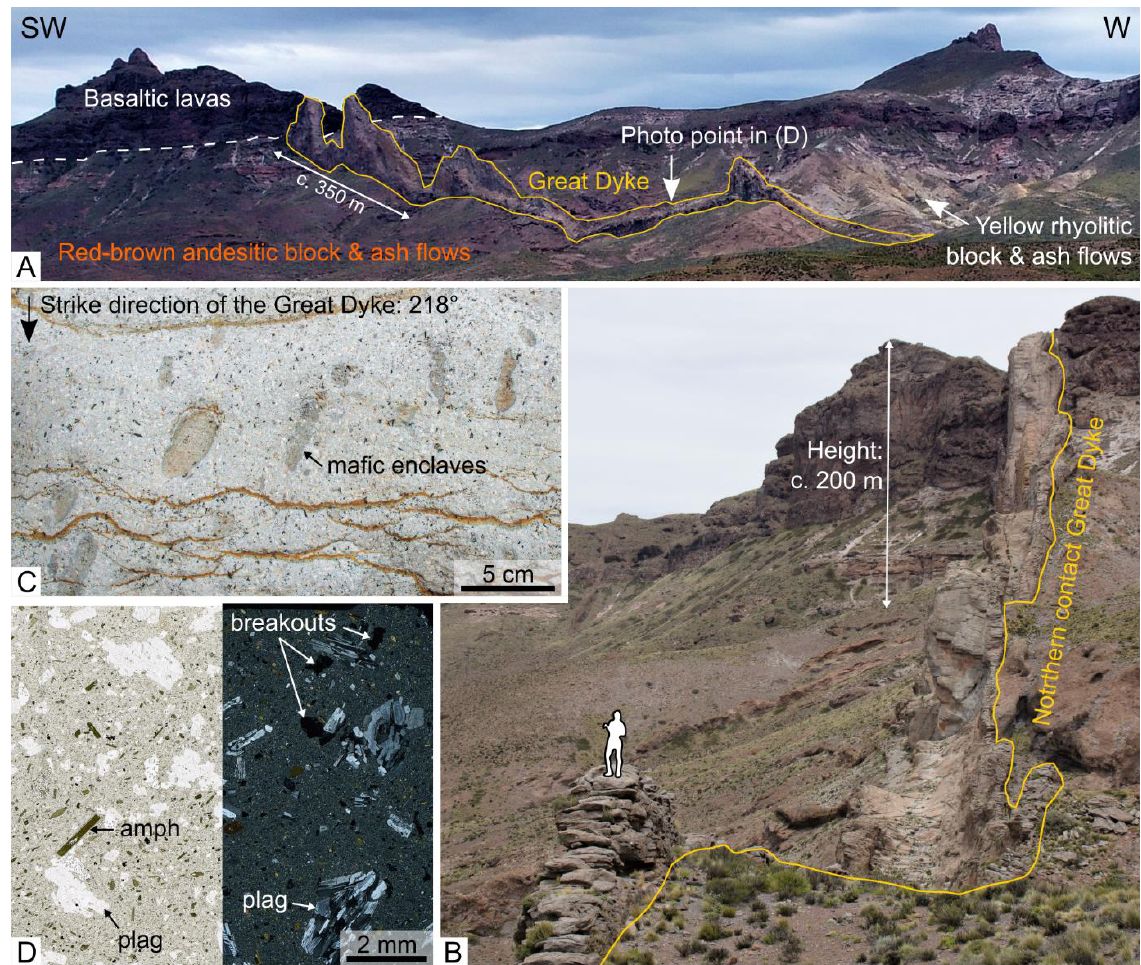
Figure 5. Great Dyke features: ( A ) Overview of the Great Dyke. ( B ) Outcrop photo Great Dyke along the dyke towards the southwest. ( C ) Detail photo in the centre of the Great Dyke, showing mafic enclaves with a long axis orientation parallel to the strike of the dyke. ( D ) Left: Thin section under plain polarized light (PPL), Right: crossed polarized light (XPL).